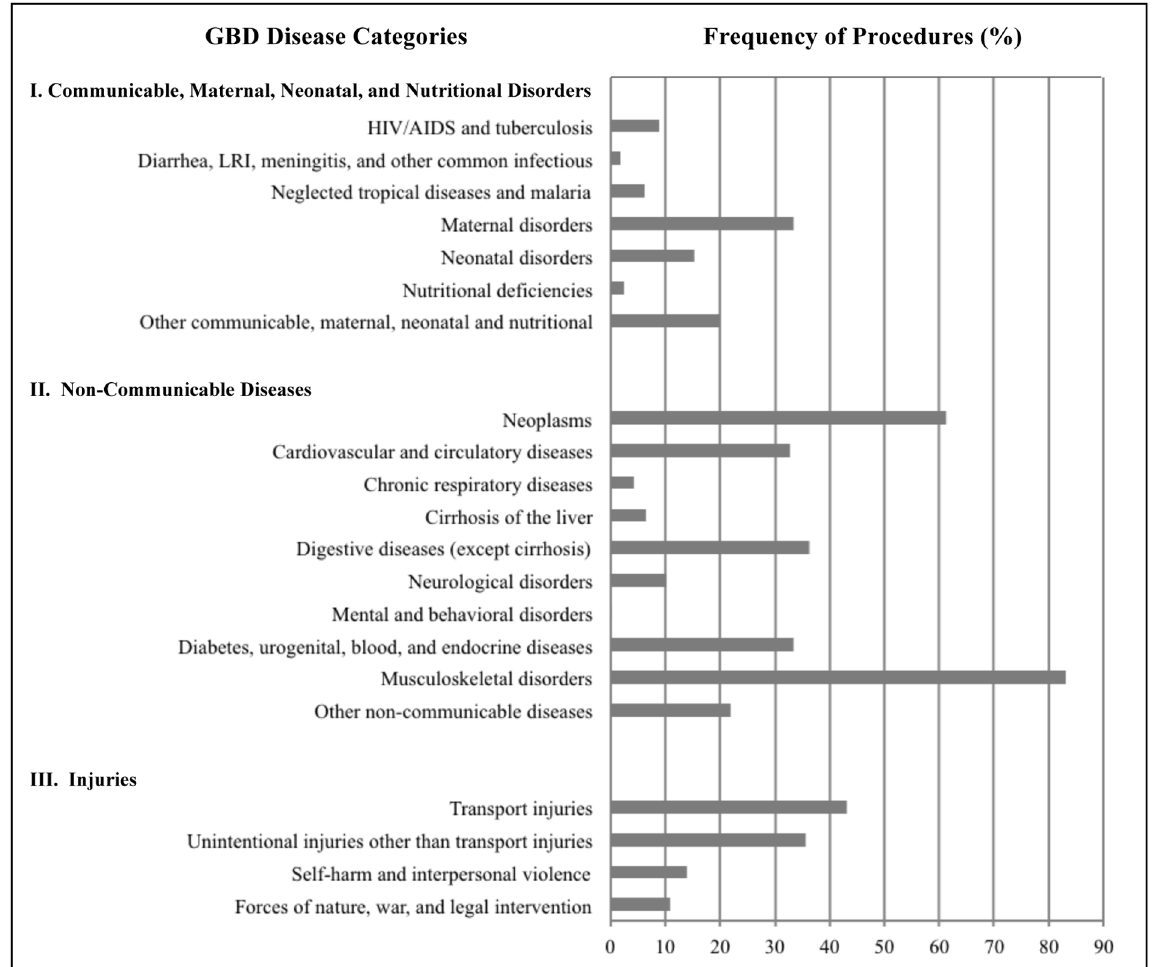
Figure 1. Percentage of inpatients undergoing a surgical procedure by disease subcategories.